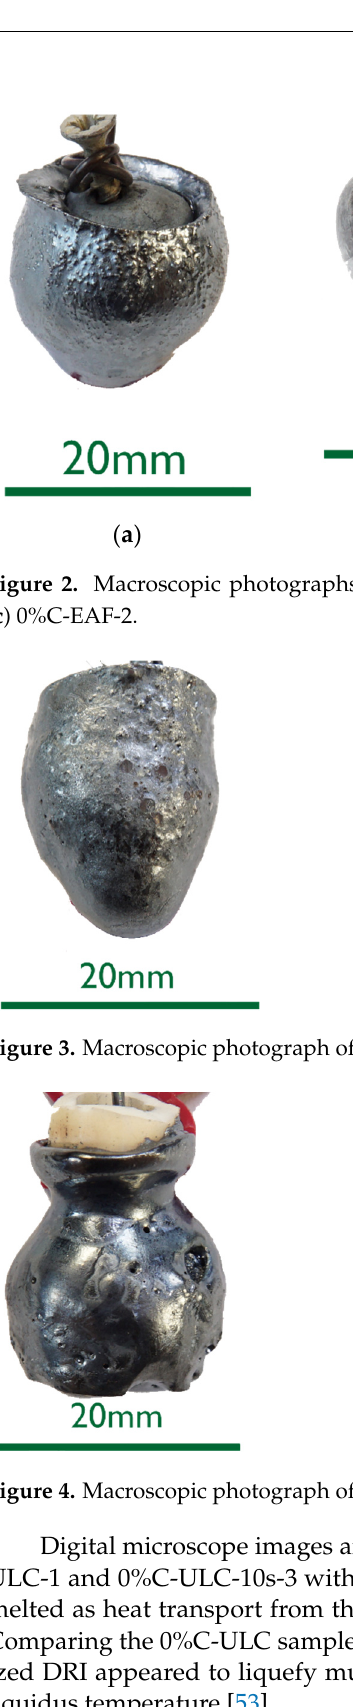
( c ) Figure 5. Macroscopic photographs of selected C800 samples: ( a ) C800-ULC-4; ( b ) C800-SAF-1; ( c ) C800-EAF-1. Figure 6. Macroscopic photograph of the sample HBI-ULC-2. Digital microscope images are shown in Figures 7 and 8 below. The sections of 0%C- ULC-1 and 0%C-ULC-10s-3 with 4 and 10 s immersion time demonstrate that the pellet melted as heat transport from the surface to the core progressed (compare Figure 7a,b).